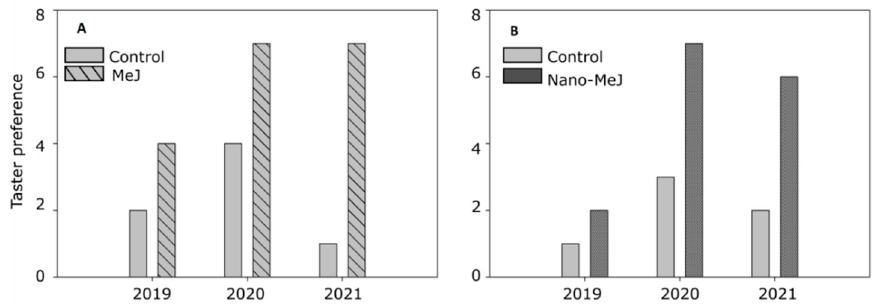
Figure 3. Triangular sensorial analysis of wines. ( A ) Wines from untreated grapes (control) vs. grapes treated with MeJ. ( B ) Wines from untreated (control) vs. grapes treated with Nano-MeJ. Bars show the number of tasters who preferred each wine.